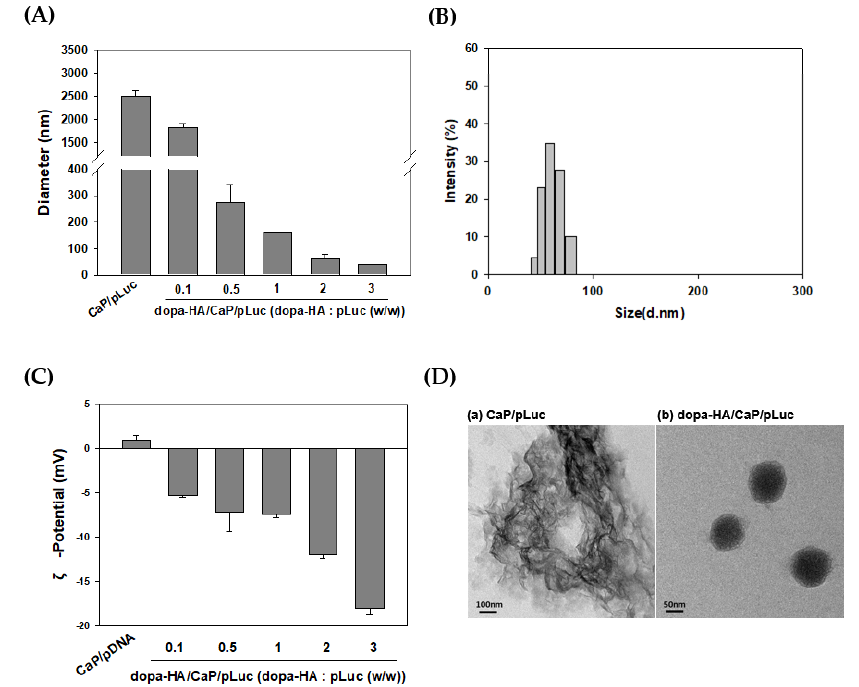
Figure 2. ( A ) Hydrodynamic diameter of dopa-HA / CaP / pLuc at various weight ratios. Values are given as the mean ± SD of triplicates. ( B ) Hydrodynamic diameter of dopa-HA / CaP / pLuc (w / w = 2). ( C ) Surface zeta-potential of dopa-HA / CaP / pLuc at various weight ratios. Values are given as the mean ± SD of triplicates. ( D ) TEM images of (a) CaP / pLuc and (b) dopa-HA / CaP / pLuc (w / w = 2). Size bar = 100 nm (a) and 50 nm (b).